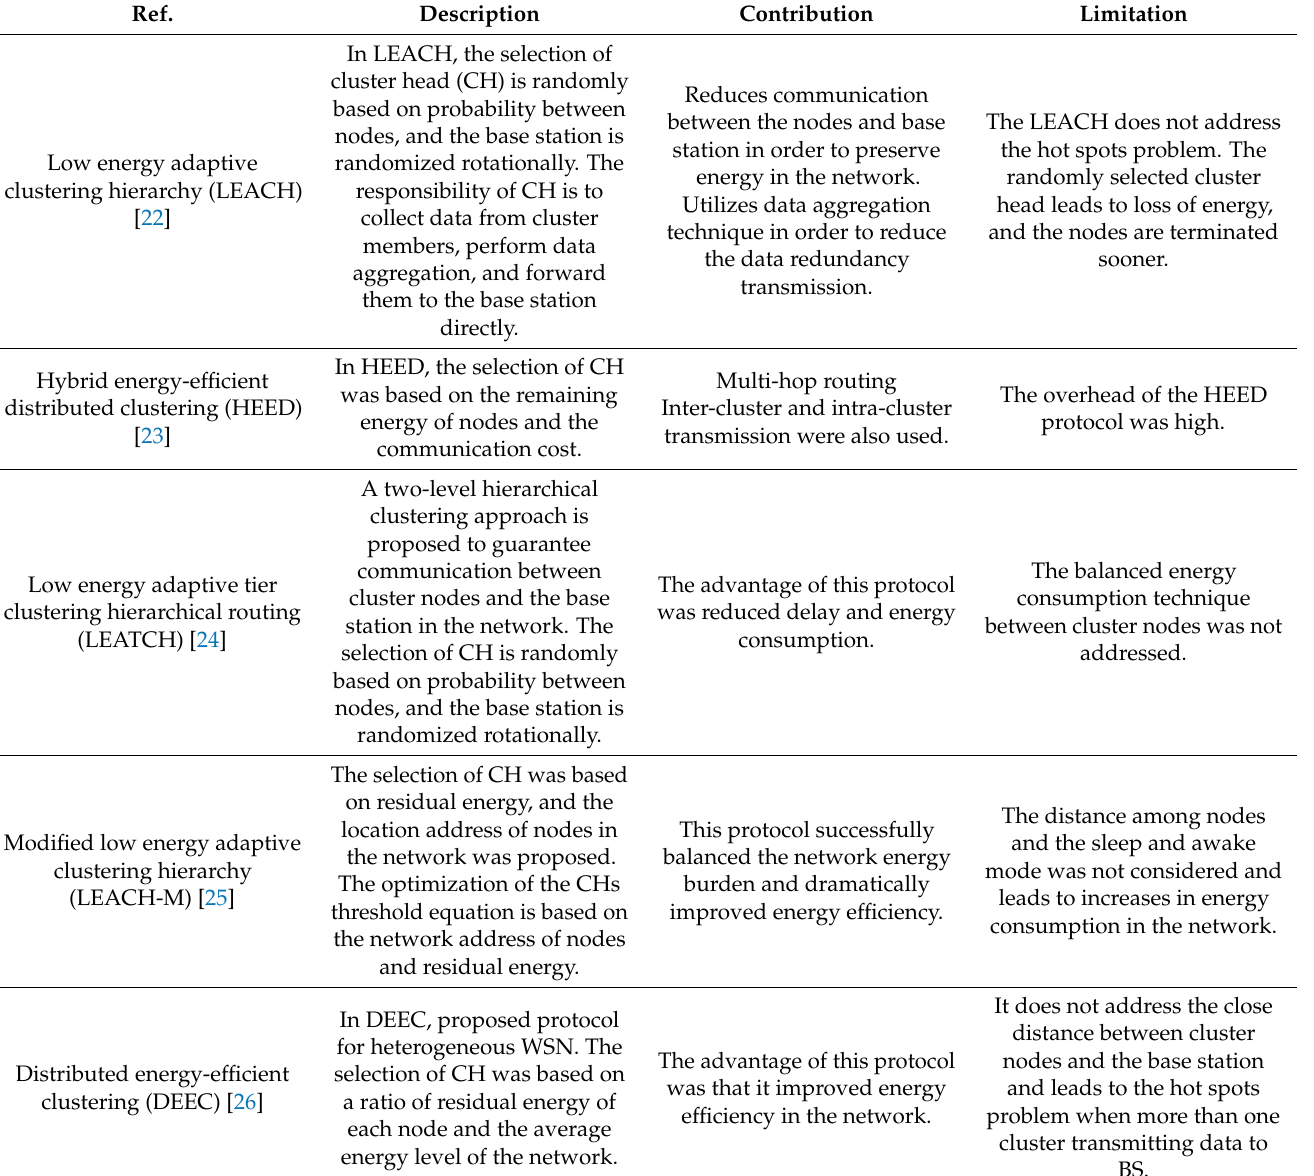
Table 1. Summary of existing